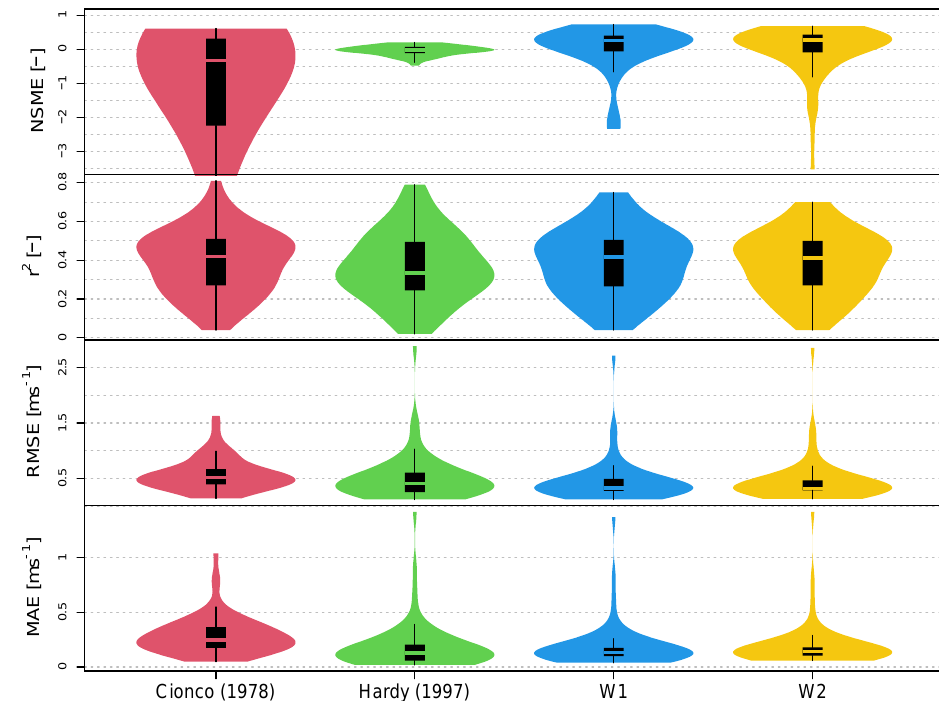
Figure 9. Comparison of efficiency criteria for new wind speed transfer functions.